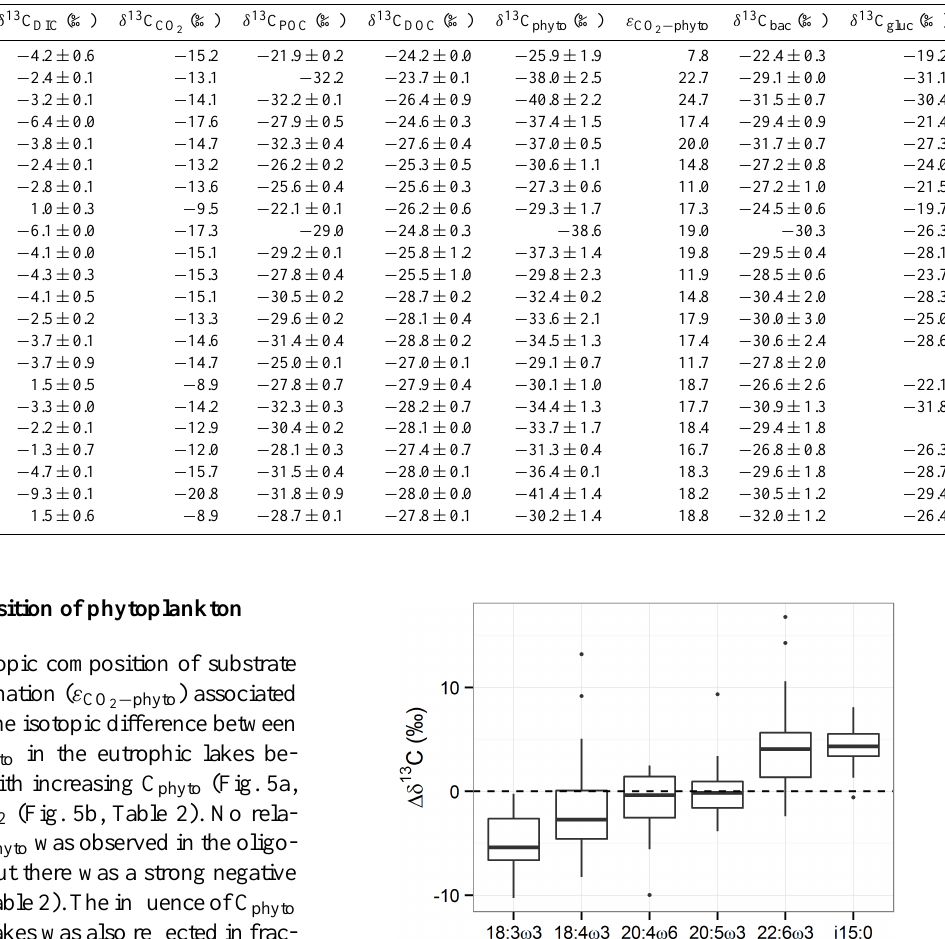
Table 3. Carbon isotope values of sampled lakes. Isotope data are presented as average ± SD ( n = 3). δ 13 C CO (Eq. 1). δ 13 C phyto and δ 13 C bac are not corrected for the offset between fatty acids and total cells, but ε CO δ 13 C of phytoplankton.